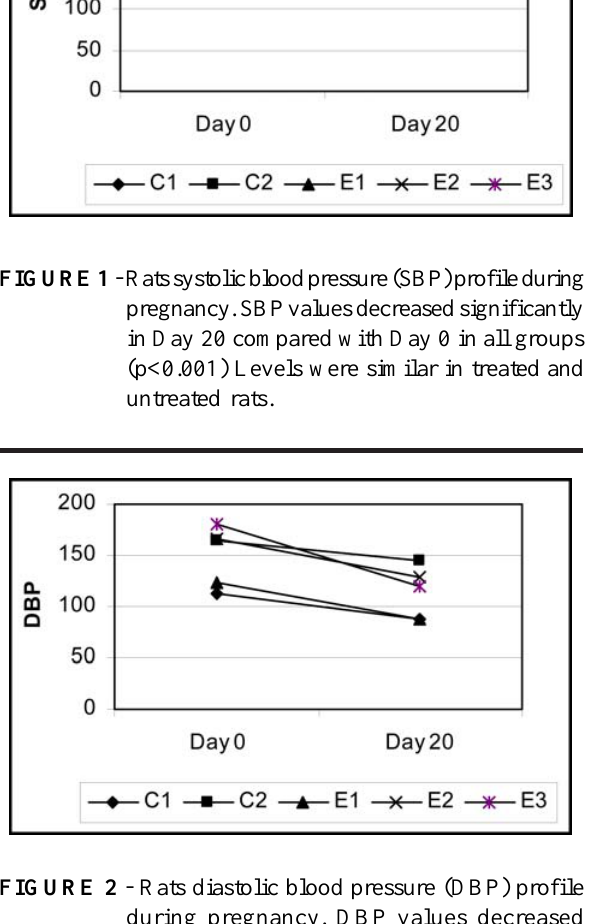
FIGURE 2 - Rats diastolic blood pressure (DBP) profile during pregnancy. DBP values decreased significantly in Day 20 compared with Day 0 in all groups (p<0.001), except